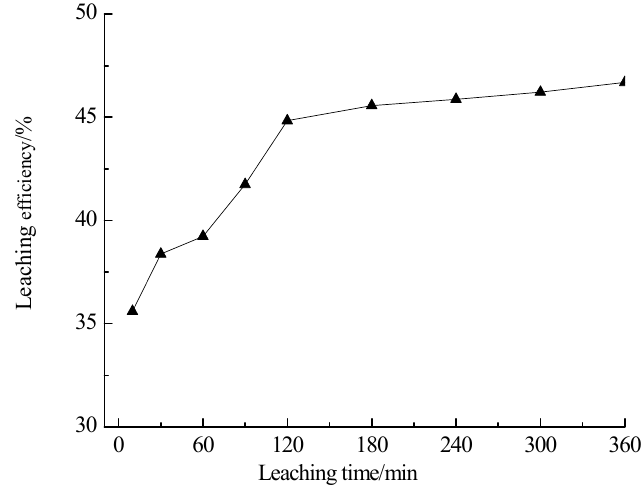
Figure 5. Effect of leaching time on zinc extraction.